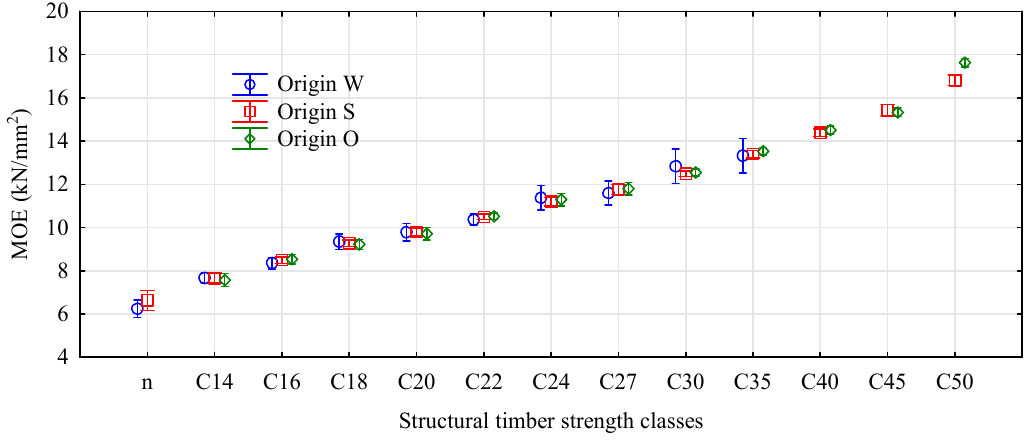
Figure 6. Timber strength classes by location. Legend: W—top logs, S—middle logs, O—butt-end logs.